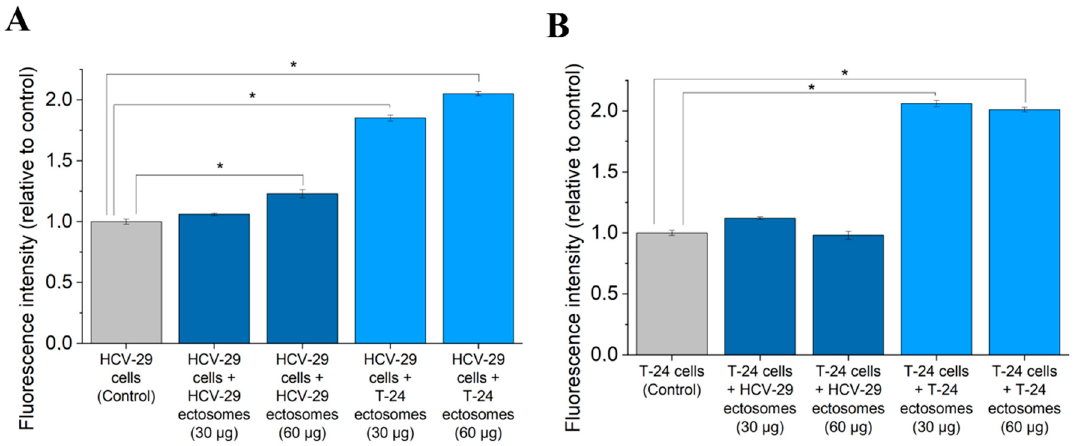
Figure 10. Effect of incubation of T-24 urothelial bladder carcinoma ( A ) and HCV-29 normal ureter epithelial cells ( B ) with ectosomes released by these cell lines. Alamar Blue cell viability assay was carried out after 18 h of incubation with ectosomes. All experiments were conducted in triplicate. “*” denotes statistically significant differences (Tukey’s post-hoc test, p -value < 0.05).